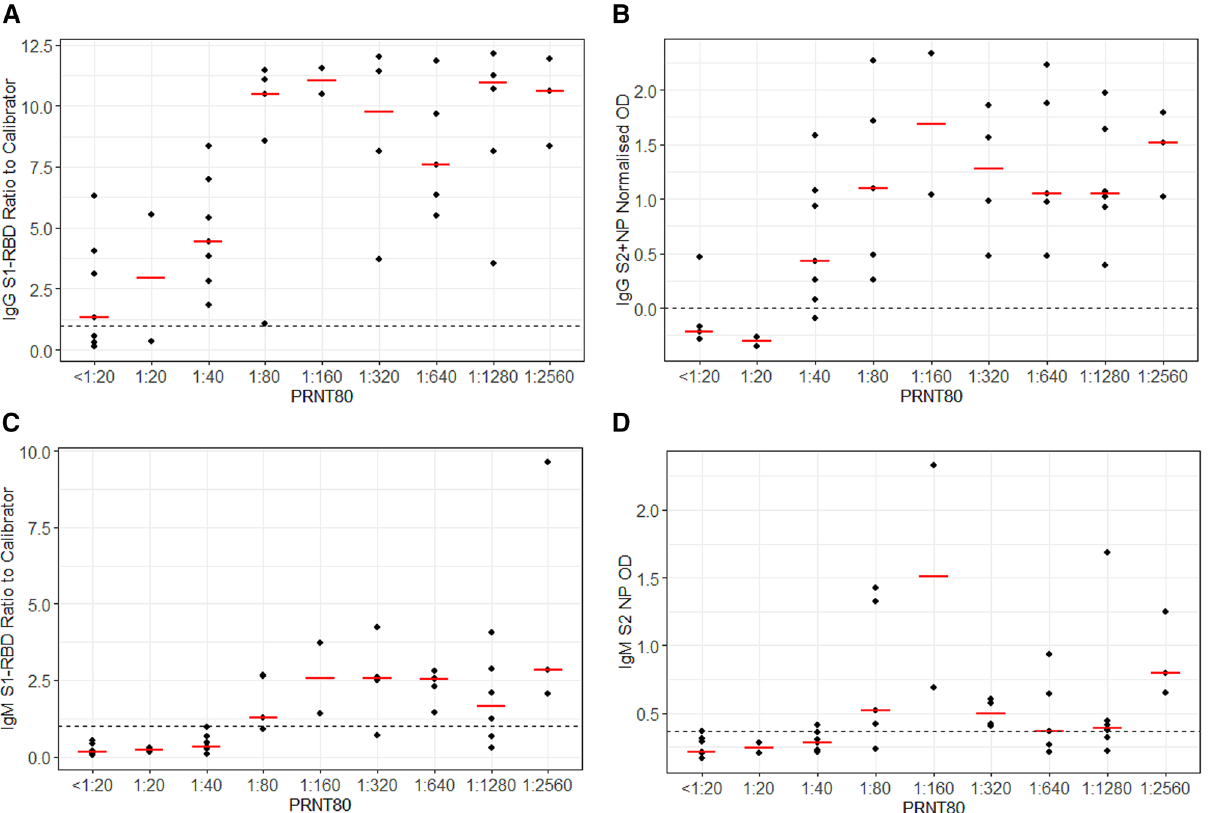
Figure 1. PRNT 80 by IgG S1-RBD ratio to calibrator ( A ); IgM S1-RBD ratio to calibrator ( B ); IgG S2 + NP NOD 450 ( C ); and IgM S2 + NP OD 450 ( D ). Median values are indicated by the red horizontal bars. The cut-off used to determine a positive sample by each ELISA is indicated by the dashed horizontal line.